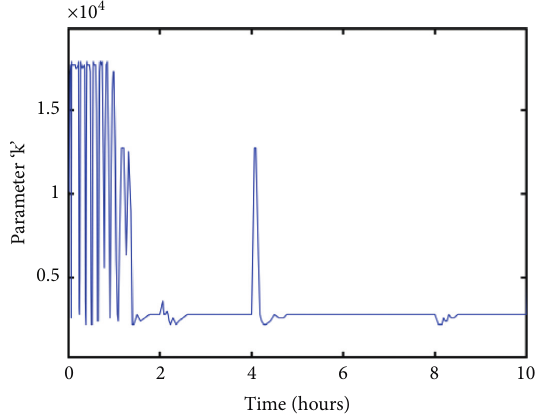
Figure 6: Output of the fuzzy control module.